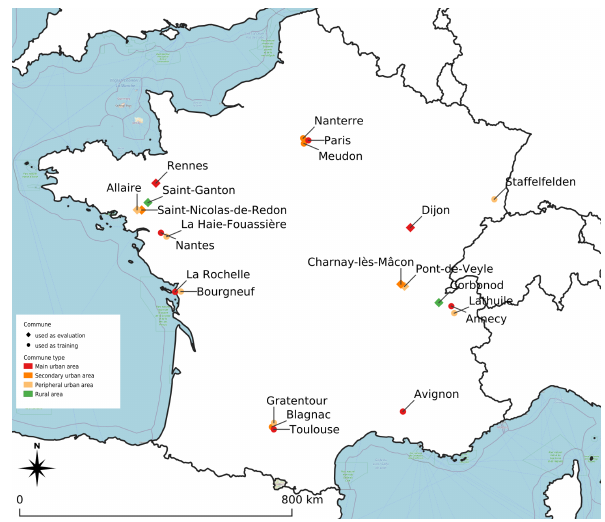
Figure 2. Location of the 22 communes used as training or evalu- ation data. ©OpenStreetMap contributors 2021. Distributed under the Open Data Commons Open Database License (ODbL)